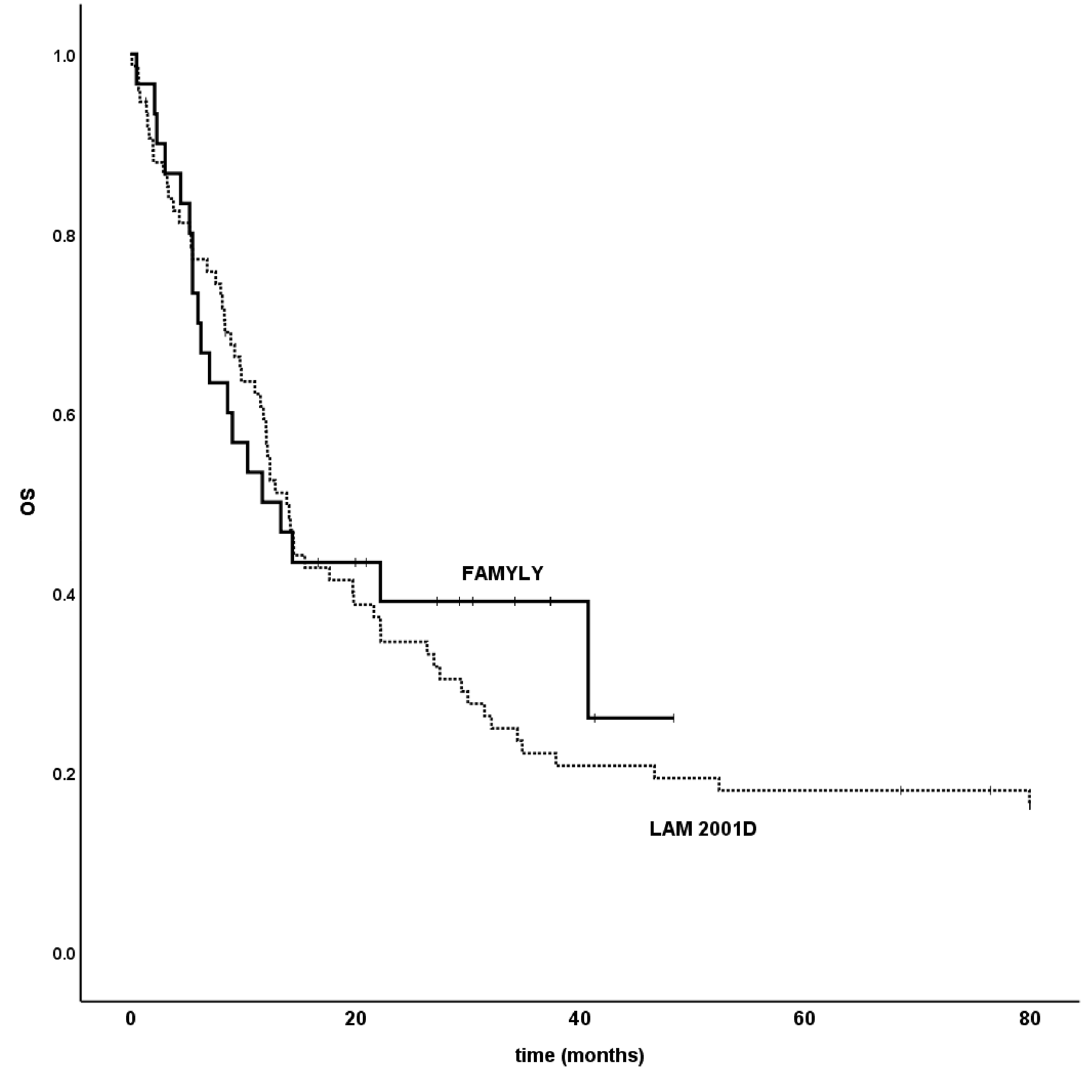
Figure 3. Historical comparison of survival data from the FAMYLY and LAM2001 trials. Overall survival (OS) was plotted from the inclusion date to the date of death or last follow up. The vertical marks indicate censored